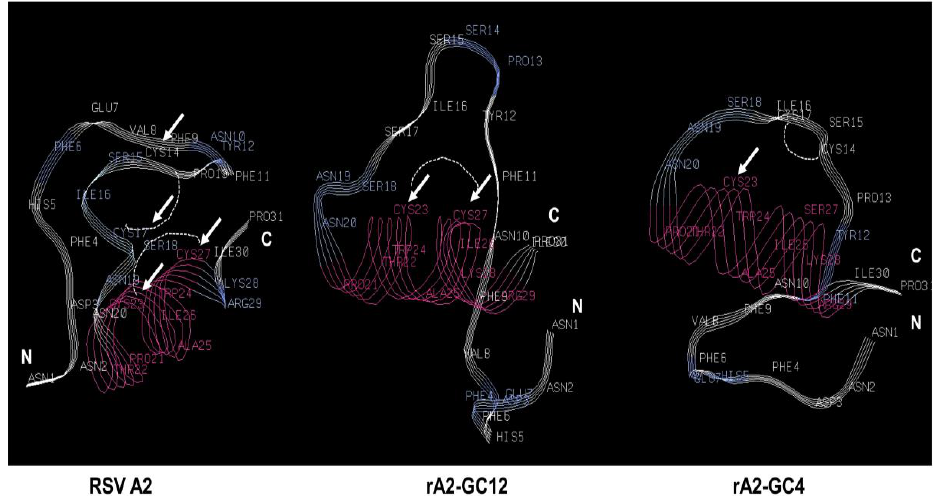
Figure 2. Mutations in the CX3C motif affect folding patterns of the cysteine noose. Peptide sequences corresponding to the RSV G protein central conserved region (CCR) were analyzed for folding pattern using Pepfold [57]. Arrows indicate positions of cysteine in the RSV A2 backbone and the changes in the rA2-GC12 and rA2-GC4 peptides.